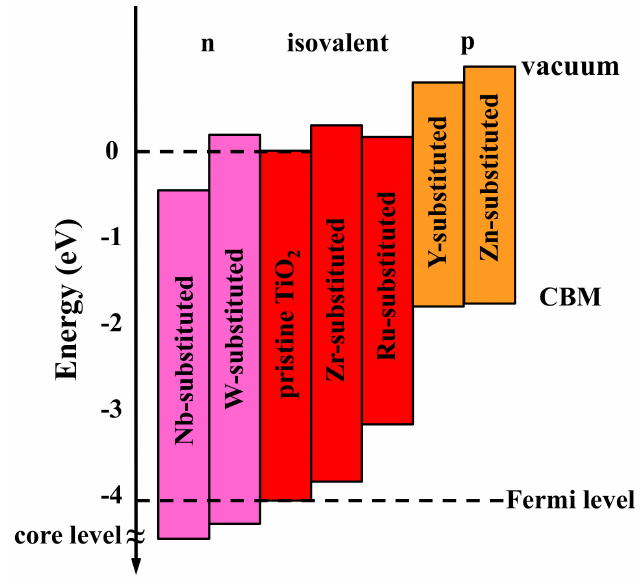
Figure 8. Schematic energy level diagram of element substituted TiO 2